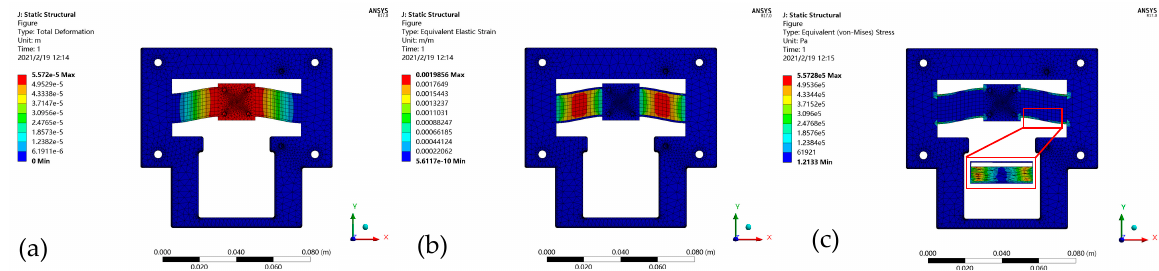
8 of 13 Table 2. Geometric parameters of the nanopositioner. Parameter